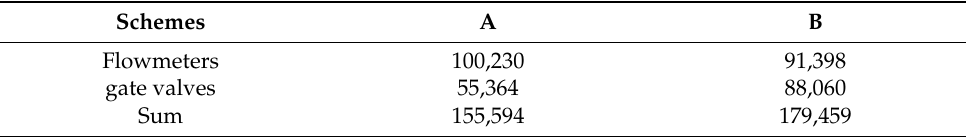
Table 2. The implementation costs of two DMA partition schemes ($). Schemes